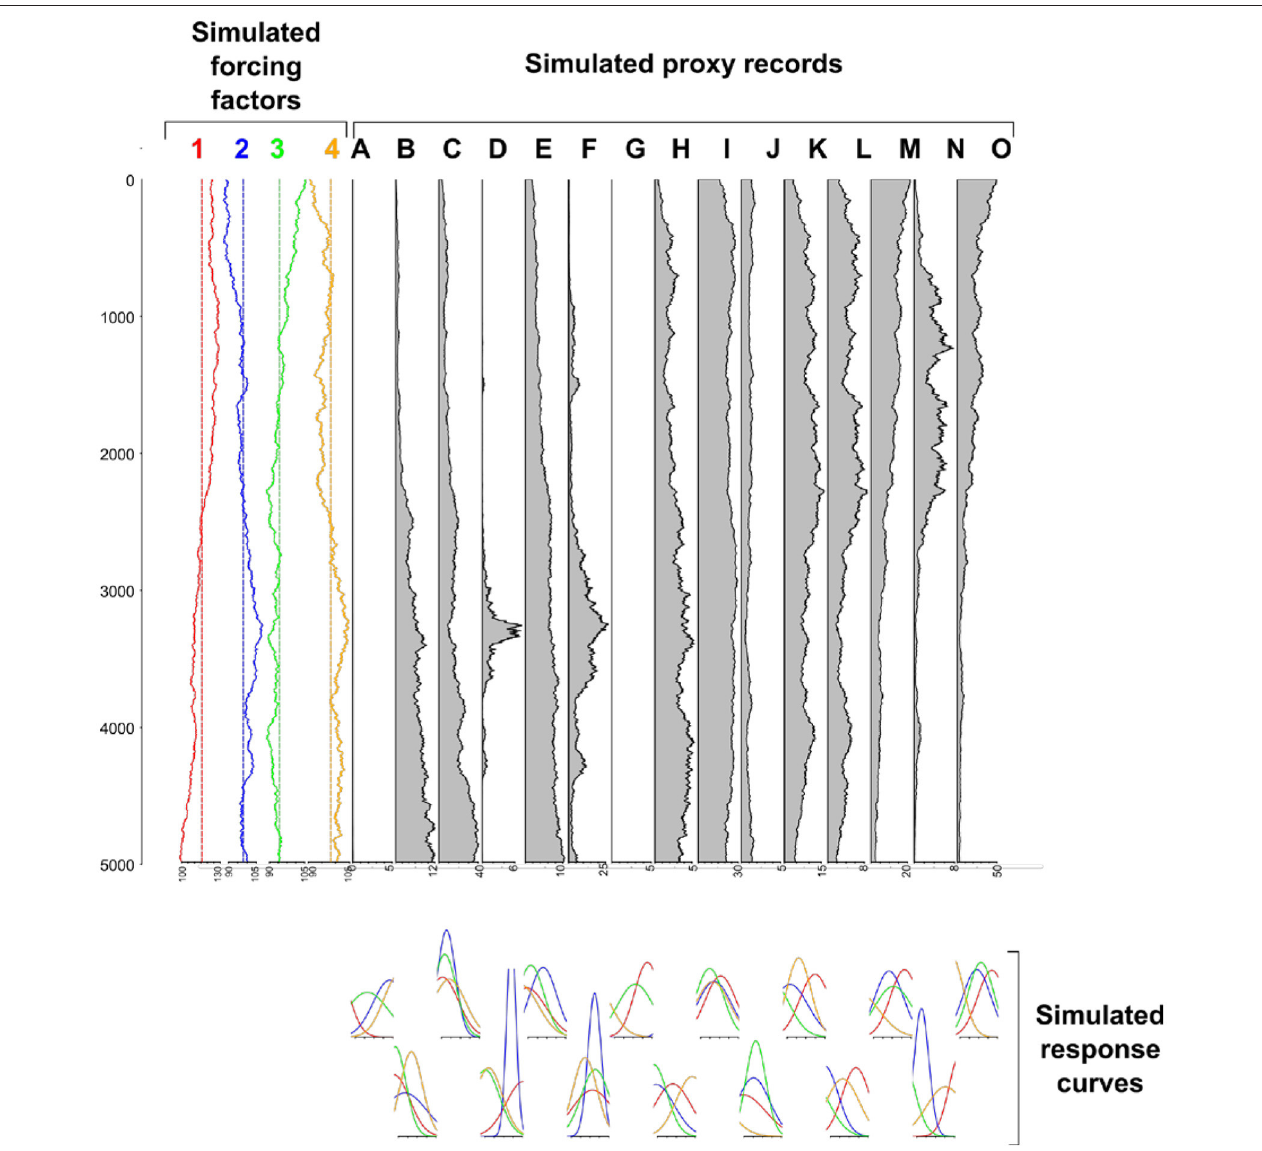
FIGURE 1 | Sample fossil pollen and exogenous forcing factor records generated with Gaussian and Poisson random walks. Although these null records show some of the visual hallmarks of “real” proxy records [e.g., long-term shifts (proxy record O) and short-term spikes (proxy record D) in dominance] they are entirely process-free. Figure generated using R code provided in Blaauw et al.